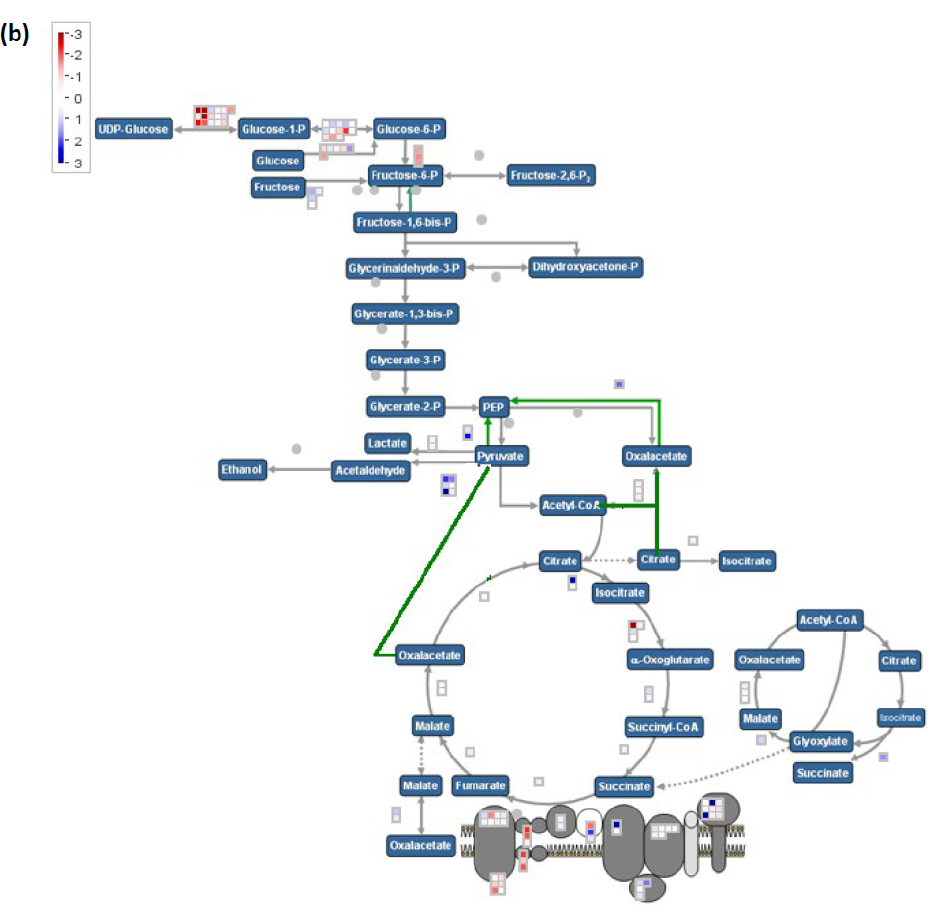
Figure 4. Mapman visualizations of the union of 20,212 (17,938 successfully mapped) differentially expressed genes (DEG) (FDR-corrected p < 0.05) of 8 pairwise comparisons between four AG tolerant lines (Nanhi Ma-Zhan Red, Khao Hlan On, Kharshu 80A, and Nanhi) and two AG susceptible varieties (IR64 and IR42). ( a ) Metabolism overview map representing 1724 DEG. DEG upregulated in AG tolerant lines are represented in blue boxes and downregulated DEG in red boxes. Grey circles indicate the absence of DEG in these bins. Black dotted trapezoid indicates pathways highlighted in ( b ). Green rounded rectangles indicate significant bins. ( b ) Glycolysis and TCA cycle map representing 124 DEG. DEG upregulated in AG tolerant lines are represented in blue boxes and downregulated DEG in red boxes. Grey circles indicate absence of DEG in these